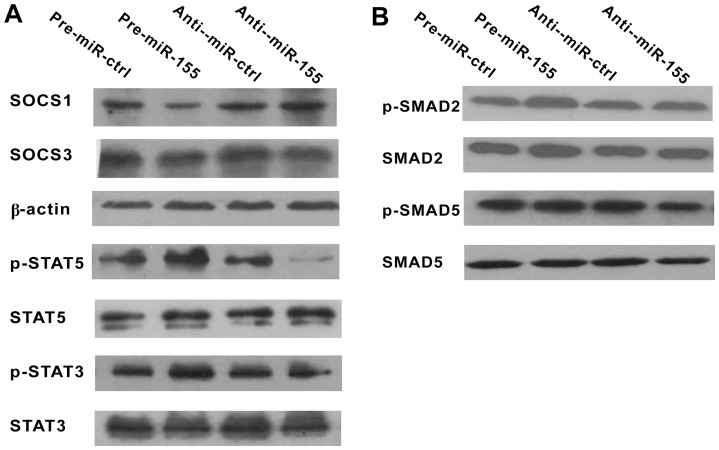
MiR-155 regulates JAK/STAT but not TGF-β/SMAD signaling pathway.4 days after pre-miR-ctrl, pre-miR-155, anti-miR-ctrl, and anti-miR-155 were transfected, activated CD4+ T cells were collected. Whole-cell lysates were prepared and the transcripts involved in Treg and Th17 cells differentiation were detected by western blotting. A. First, protein lysates were immunoblotted with SOCS1 and SOCS3, and β-actin served as the internal reference. Then, protein lysates were immunoblotted with p-STAT5/p-STAT3 and the total proteins, STAT5/STAT3. B. Finally, protein lysates were immunoblotted with p-SMAD5/p-SMAD2 and the total proteins, SMAD5/SMAD2. Representative images from one of three independent experiments are shown.